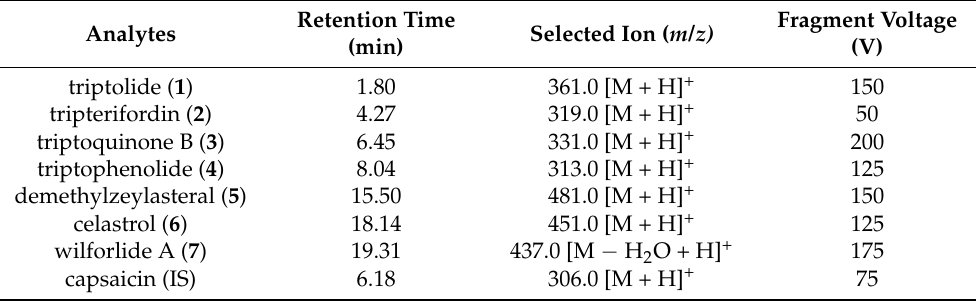
Table 1. Retention time and related MS parameters for investigated diterpenoids, triterpenoids, and IS.